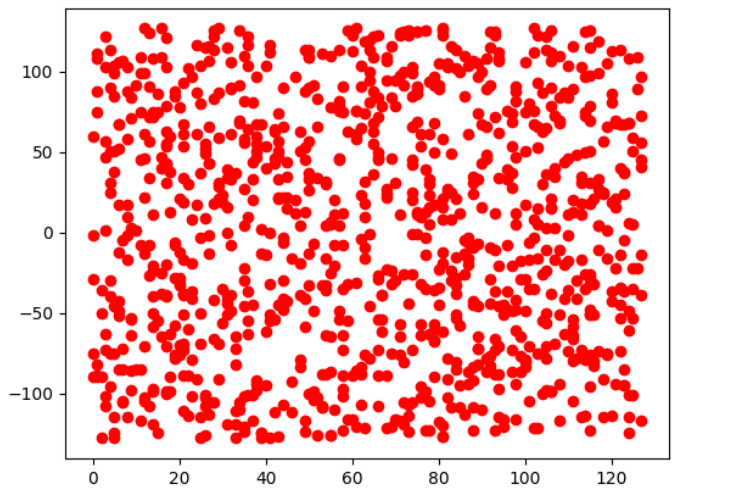
Figure 2. Distribution of random data points generated in 1000 rounds.